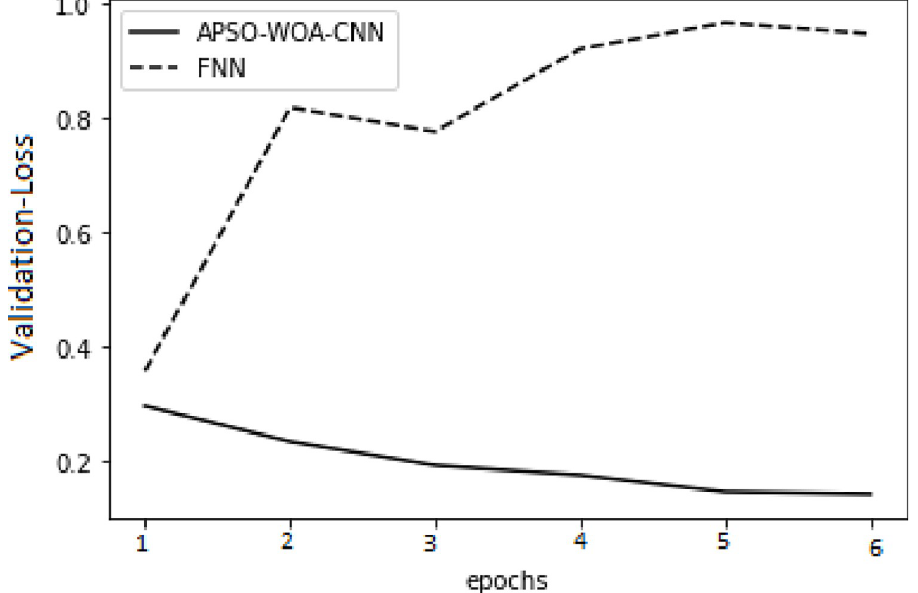
Fig 7. APSO–WOA–CNN and FNN algorithms’ loss function validation